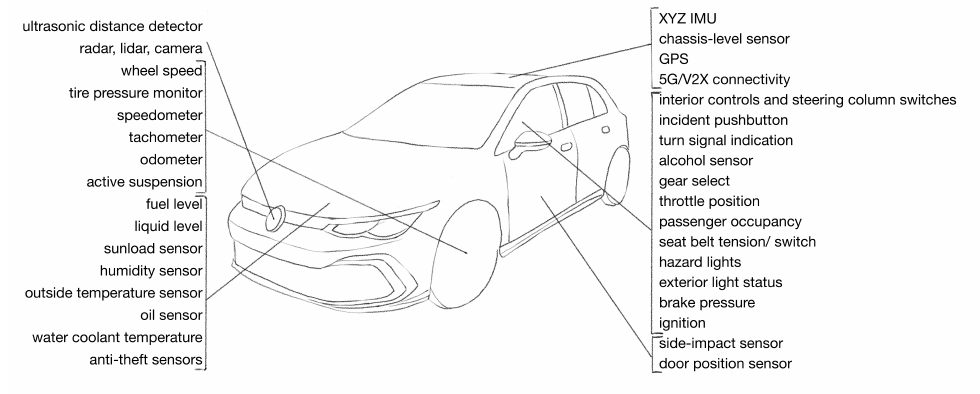
Figure 4. Sensors in a